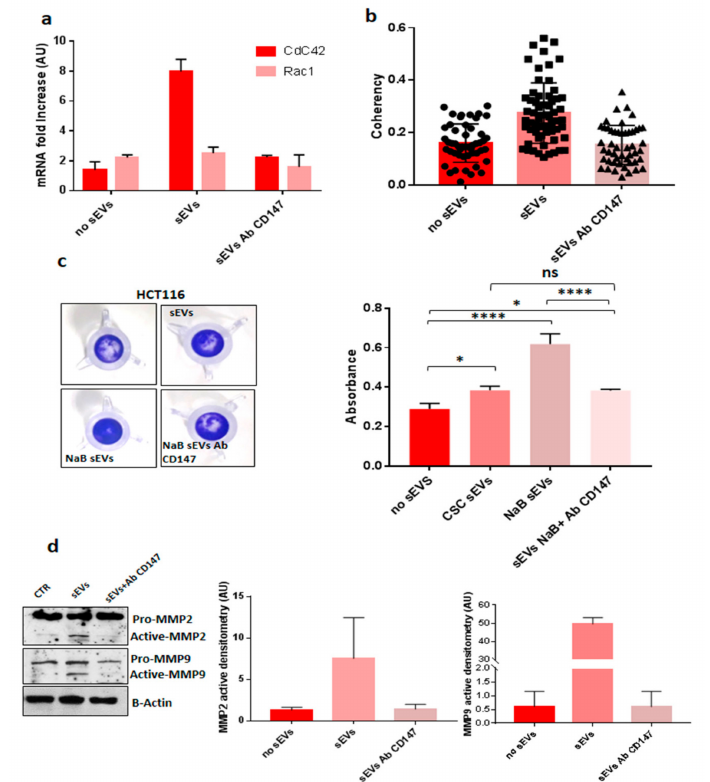
Figure 10. CD147carriedbysEVs(smallextracellularvesicles)affectsCDC42expression, actinorganization and invasive capacity of recipient cells. ( a ) CR-CSC-sEVs administrated to HCT116 induced an increase of CdC42 expression compared to untreated cells; pre-treatment of sEVs with CD147 antibody prevented the activation of CdC42 expression. ( b ) Analysis of actin cytoskeleton of HCT116 treated with sEVs compared to untreated cells; pre-treatment of sEVs with anti-CD147 antibodies prevented their effect on actin organization; ( c ) invasive assay of HCT116 treated with sEVs: CD147-sEVs increased the invasive potential of recipient cells; ( d ) blocking CD147 on sEVs surface prevented the activation of MMP2-MMP-9 expression. Densitometry of activated MMP2 and MMP9 Data shown are representative of three independent experiments. No sEVs = HCT116 sEVs untreated; sEVs = HCT116 cells treated with Re121-sEVs; sEVs Ab Cd147 = HCT116 cells treated with sEVs CD147 blocked with antibody; NaB sEVs = sEVs released by Re121 differentiated with 10% FBS, maintained in absence of growth factors and treated after seven days with 2 mM NaB; CSC sEVs = HCT116 treated with sEVs released by Re121 CR-CSC; sEVs + Ab Cd147 = HCT116 treated with sEVs released by Re121 CR-CSC and CD147 blocked with antibody. *, p ≤ 0.05; **; ****, p ≤